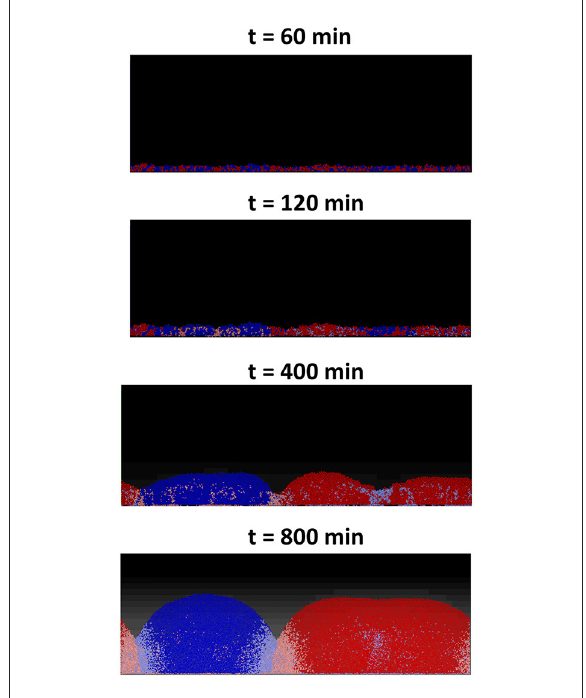
FIGURE6 An individual-based model of a competition between two toxin producing strains, growing together as a biofilm starting from an initial mixed layer of cells. The two strains gradually segregate into two distinct clusters. The cells lying at the clusters’ boundaries are experiencing negative growth, due to the toxins’ effect, and the further a cell lies from the clusters’ boundaries, the lower the damage it